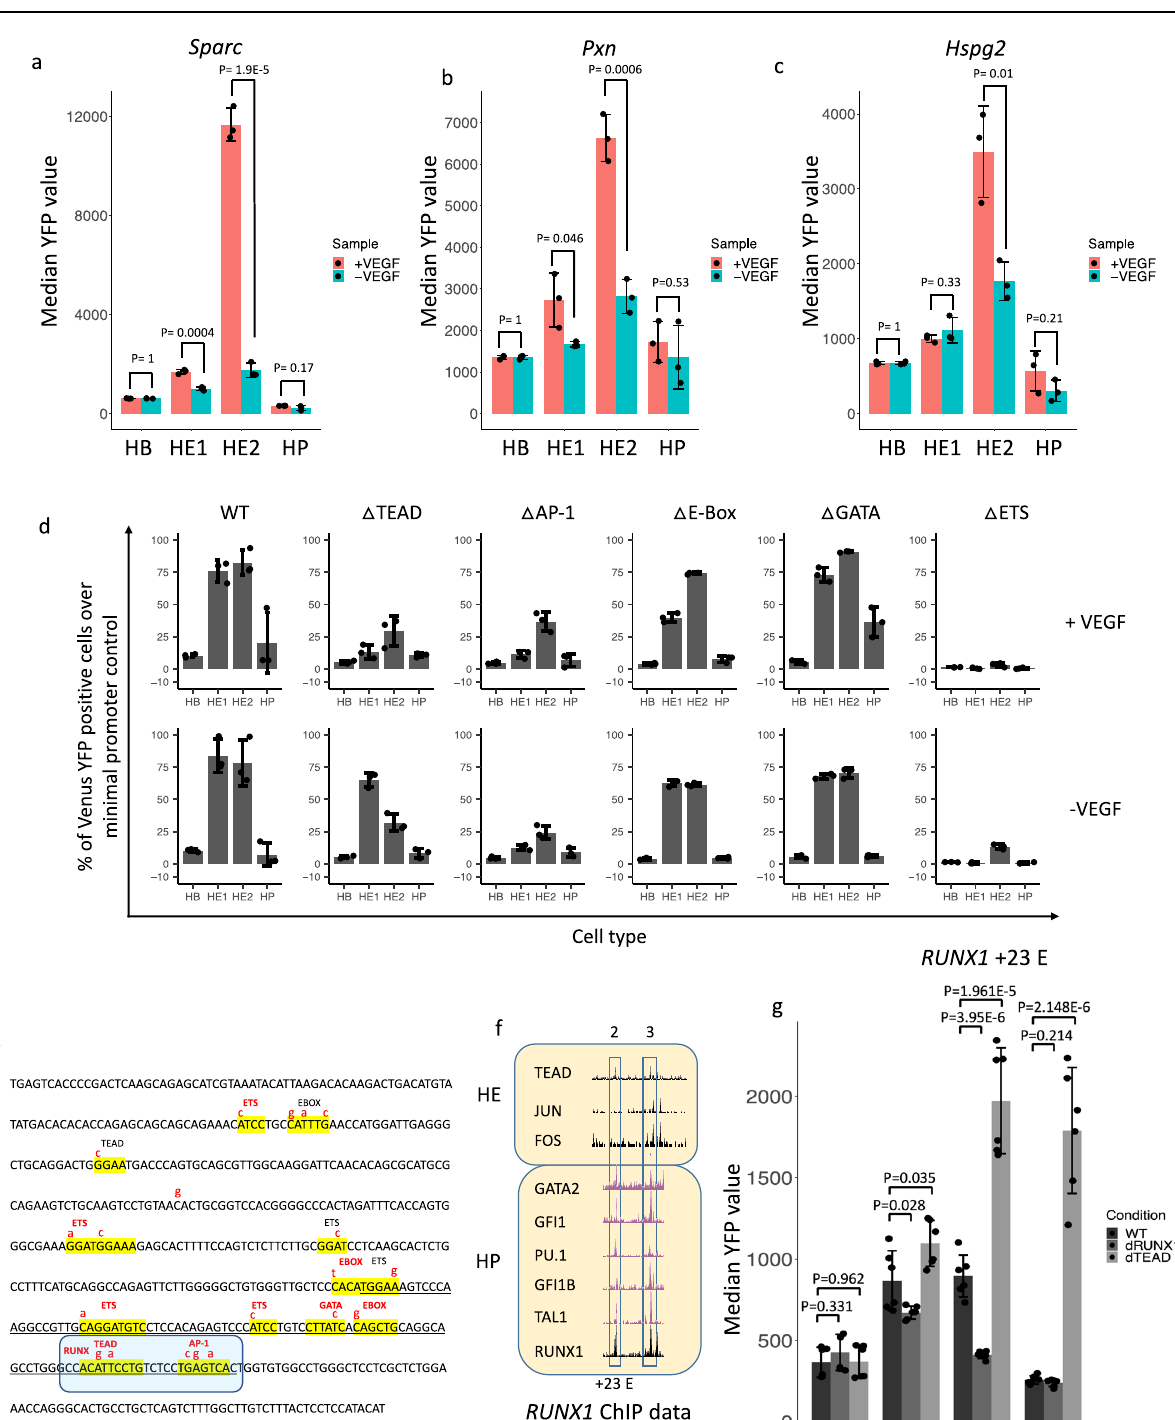
Fig.7|HE-speci fi candcytokineresponsivegeneexpressionismediatedbythe interplay of TEAD, AP-1 and RUNX1. a – c Activity of the Sparc, Pxn and Hspg2 enhancers (for details see Supplementary Notes) in isolation in the presence and absence of VEGF. Data are presented as mean values+/ − SD. Dots showing indi- vidual values for n =3 biologically independent experiments. P -values calculated using a two-sided Student ’ s t -test. Source data are provided as a Source Data fi le. d HE-speci fi c expression of Galnt1 (data from ref. 18 ), reporter gene activity driven by wild type (WT) and mutated Galnt1 enhancer elements in the presence and absence of the indicated cytokines. Data are presented as mean values+/ − SD.